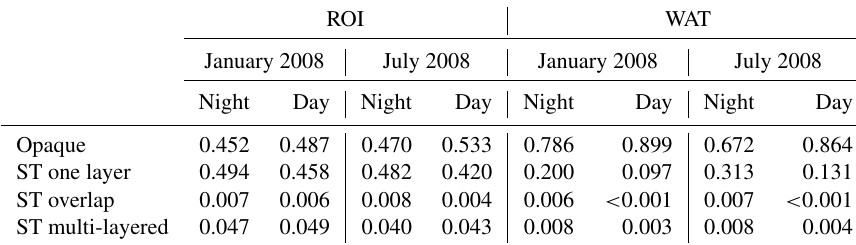
Table 2. Detailed statistics for IIR pixels with only ROI or WAT high-confidence layer(s) in the column and no cleared clouds for retrievals with background radiance from the ocean surface between 60 ◦ S and 60 ◦ N in January and July 2008: fraction of opaque clouds, single- layered ST clouds, ST clouds with two overlapping layers, and multi-layered ST